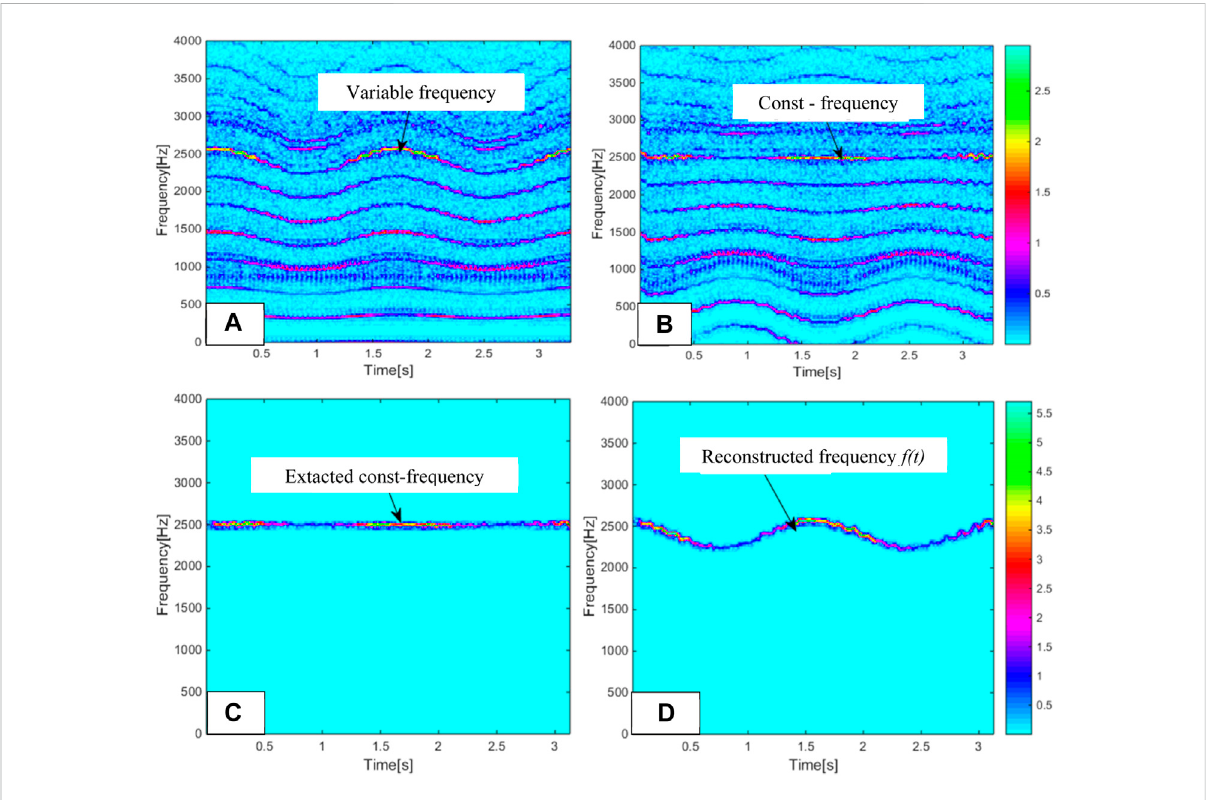
FIGURE 2 Simulation generalized Fourier transform for a component